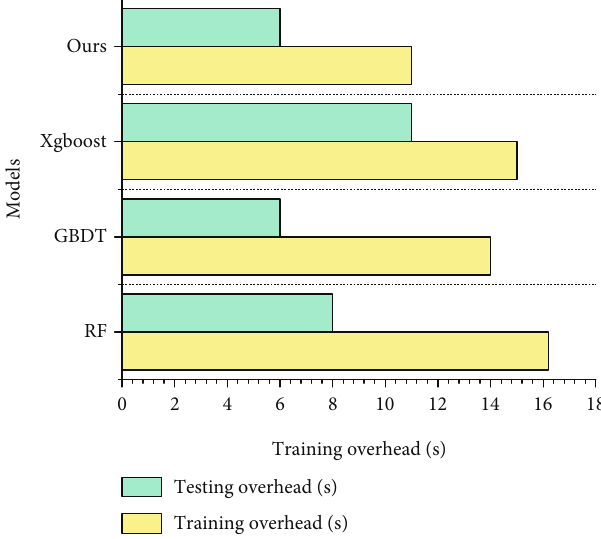
Figure 7: Comparison of training and testing time overhead of di ff erent models. Figure 8: E ff ect of di ff erent metrics on overall